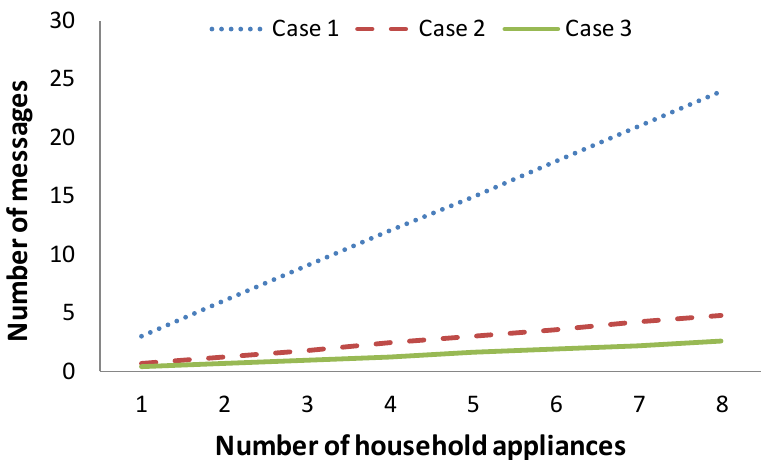
Figure 7. Number of messages in our system as a function of the number of household appliances.